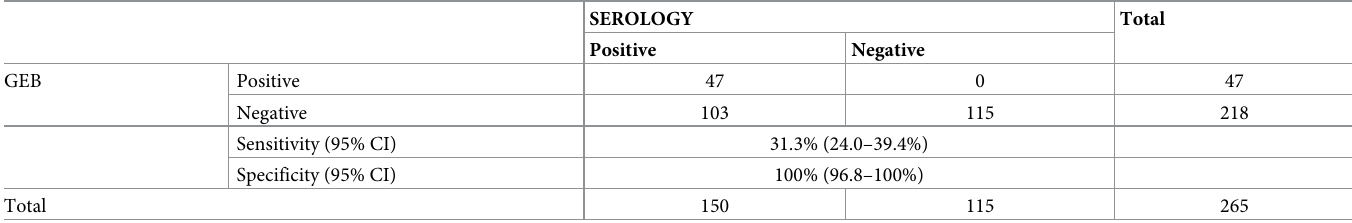
Table 1. Comparison of qPCR to serology using DNA extracted from GEB.